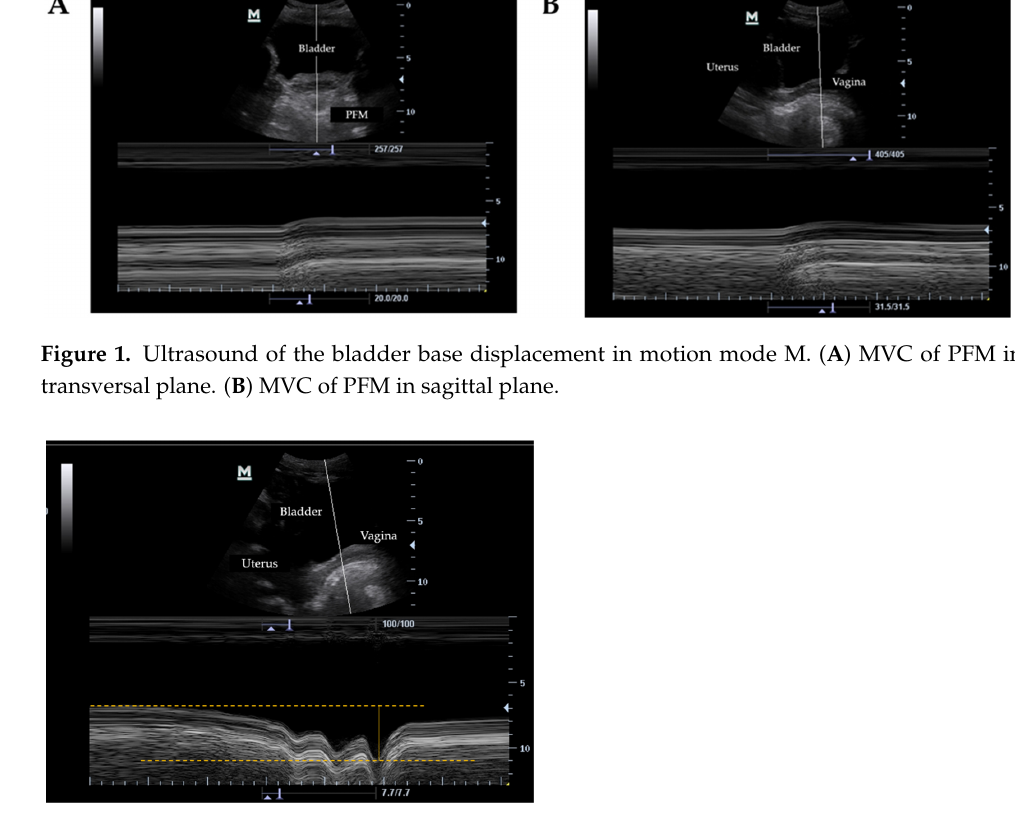
Figure 2. Ultrasound measurements of the bladder base displacement during a cough in sagittal plane. In the top of the figure pelvic structures are shown. Below is represented the timeline of M mode. The dotted horizontal lines represent the bladder base in rest position and the position during a cough. The vertical continued line shows the bladder displacement.